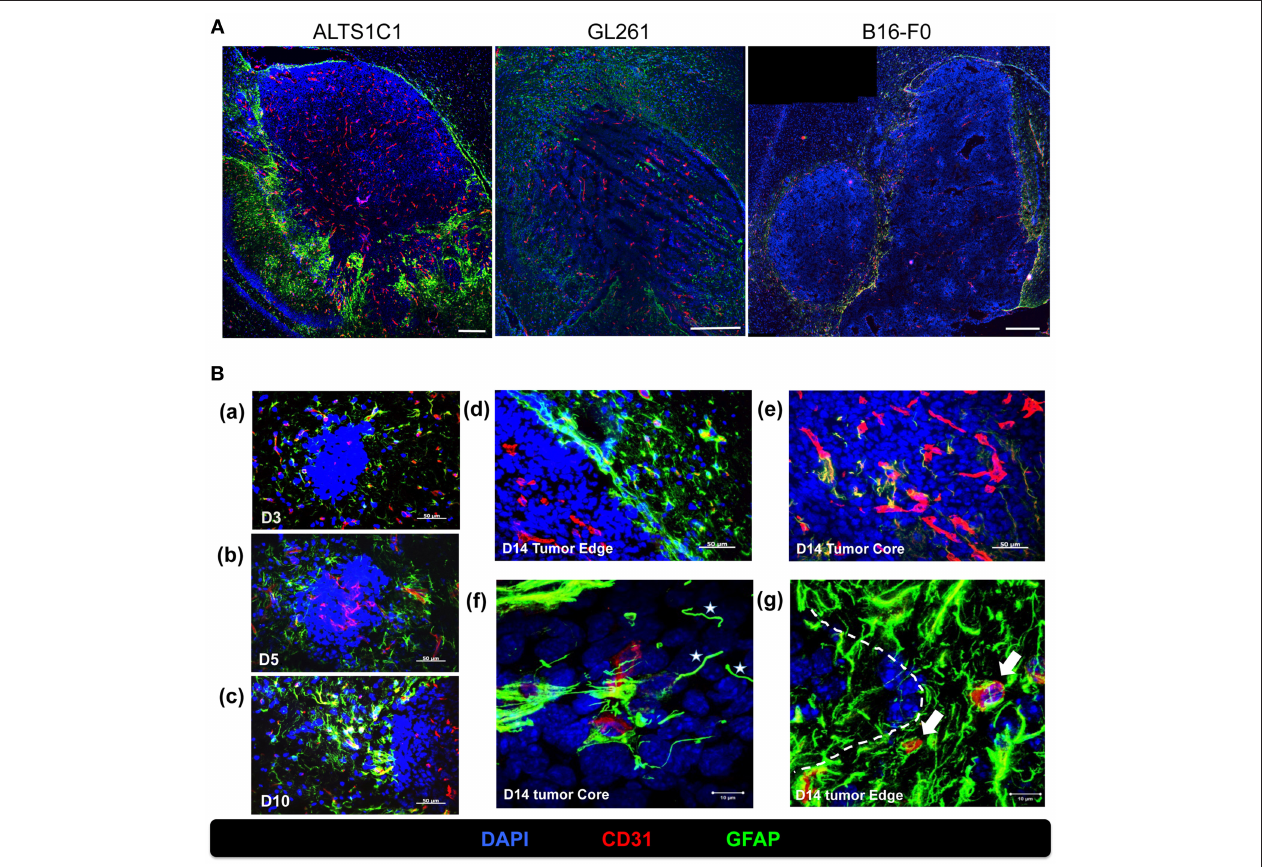
FIGURE 6 | Activated astrocytes surrounded the tumor border during tumor progression. (A) The correlation of vasculatures and astrocytes pattern was examined in orthotopic tumors, including astrocytoma ALTS1C1, glioma GL261, and melanoma B16-F0 tumors. Brain tumor tissues were double stained with GFAP (green) and CD31 (red). Scale bar = 400 µ m. (B) Mice were sacrificed on day 3 (a), day 5 (b), day 10(c), and day 14 (d,e) after I.C. inoculation of ALTS1C1 brain tumor. Tumor sections were double staining for GFAP (green) and CD31 (red). Nucleus was stained with DAPI (blue). Scale bar = 50 µ m. (f,g) Representative images at day 14 captured by confocal microscope. White stars marked vessel-like astrocytes (f) and white arrows indicated activated astrocyte-attached vessels (g). Tumor boundary was outlined by white dotted line. Scale bar = 10 µ